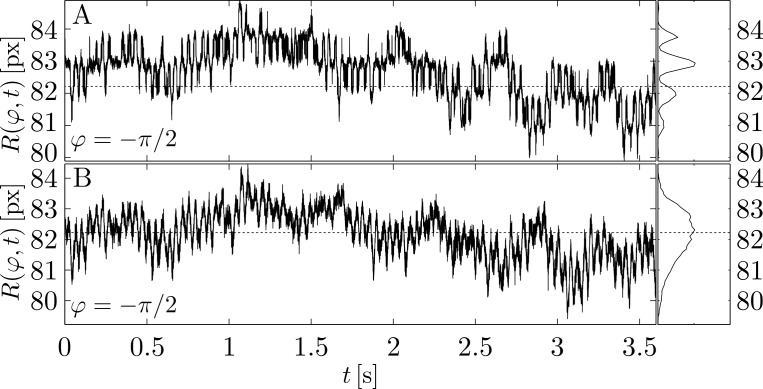
Comparison of the radius fluctuation time-series obtained from a measurement of a POPC GUV using Pécréaux’ algorithm (A) and our algorithm (B). The artifacts from imprecise fitting leads to various maxima in the displacement-distributions spaced 1px apart. This artifact is not present when using our new method.